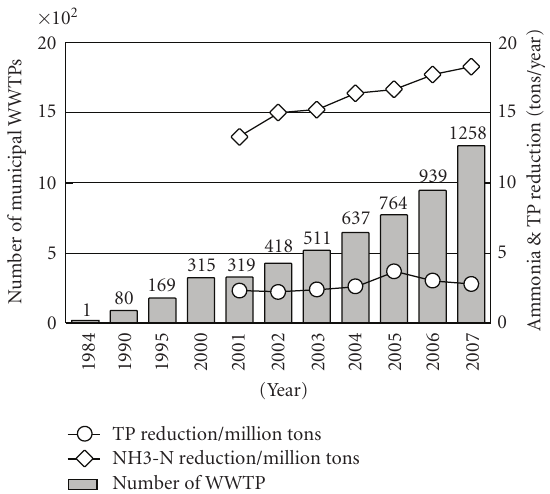
Figure 1: Nutrients reduction in municipal WWTPs based on treated wastewater in China.